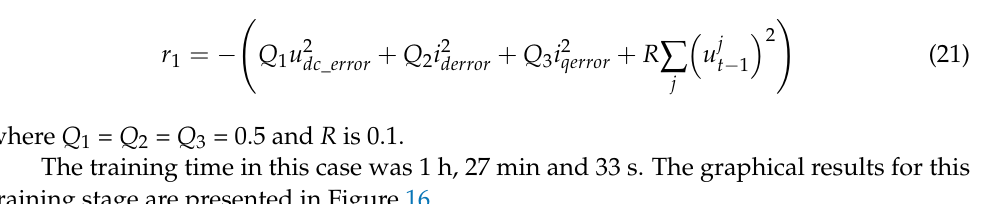
Figure 16. The training stage of the RL-TD3 agent for the correction of the u dref , u qref and i dref com- mands. 5. Correction of the Control Signals for the Control System of the Grid Connected PV Array Based on SMC and Synergetic Controllers Using the RL-TD3 Agent In this section, we present the design and synthesis algorithms of the SMC and SYN controllers of the control system for the GC-PV array. Figure 17 presents the schematic diagram of the control system for the GC-PV array based on the SMC and SYN control- lers. This control system consisted of a cascade in which the control loops were used for